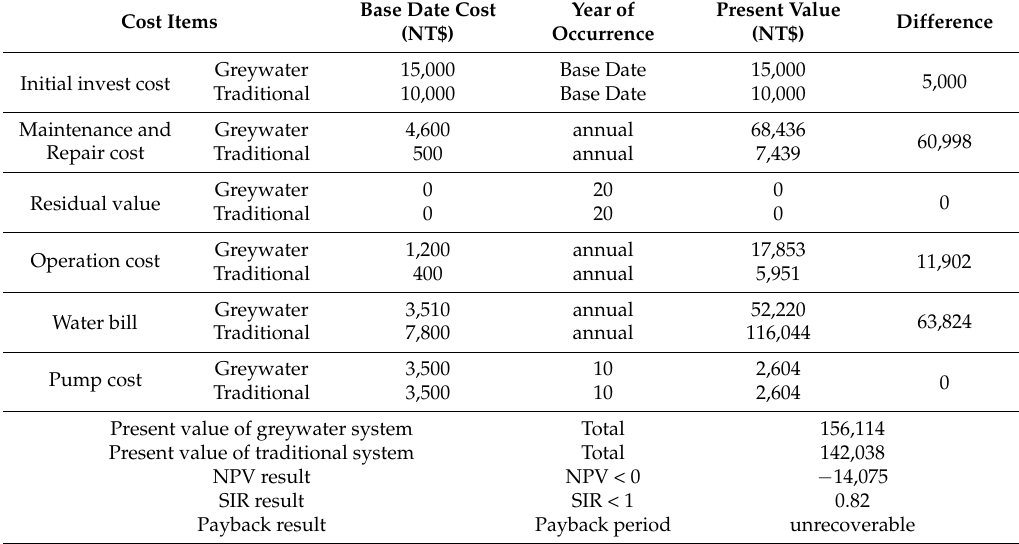
Table 2. Economic analysis of scenario 1.